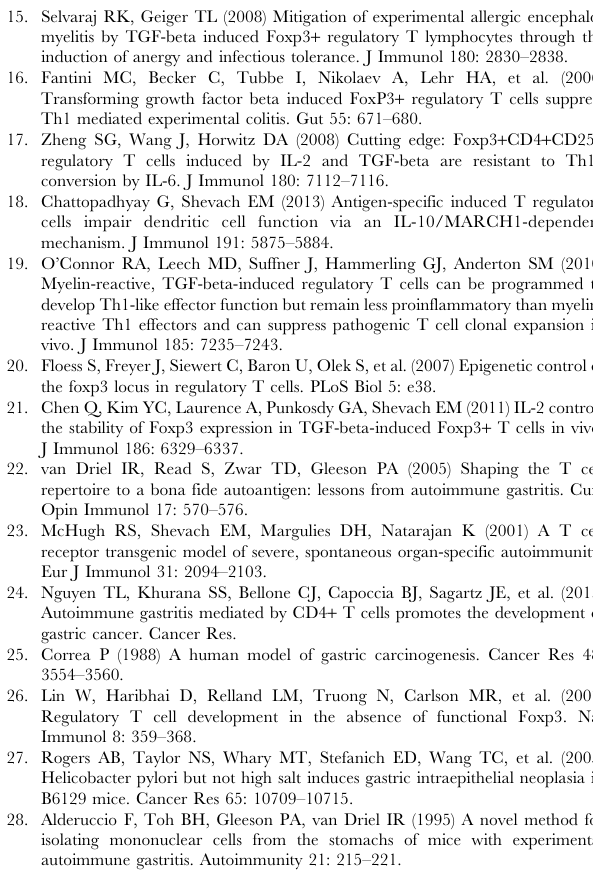
Figure S1 Comparison of inhibitory receptors ex- pressed by enTregs and iTregs. (A) Representative histo- grams generated using flow cytometric analysis of surface receptors expressed by iTregs (black line) isolated from the gastric lymph nodes TxA23 mice 1 week after treated and enTregs (gray filled line) from age matched untreated TxA23 mice. Data represents an aggregation of 2-4 individual experiments. Figure S2 iTregs upregulated surface receptors after transfer into TxA23 mice. (A) Representative histograms generated using flow cytometric analysis of surface receptors on iTregs prior to transfer (gray filled line) and iTregs 1 week after